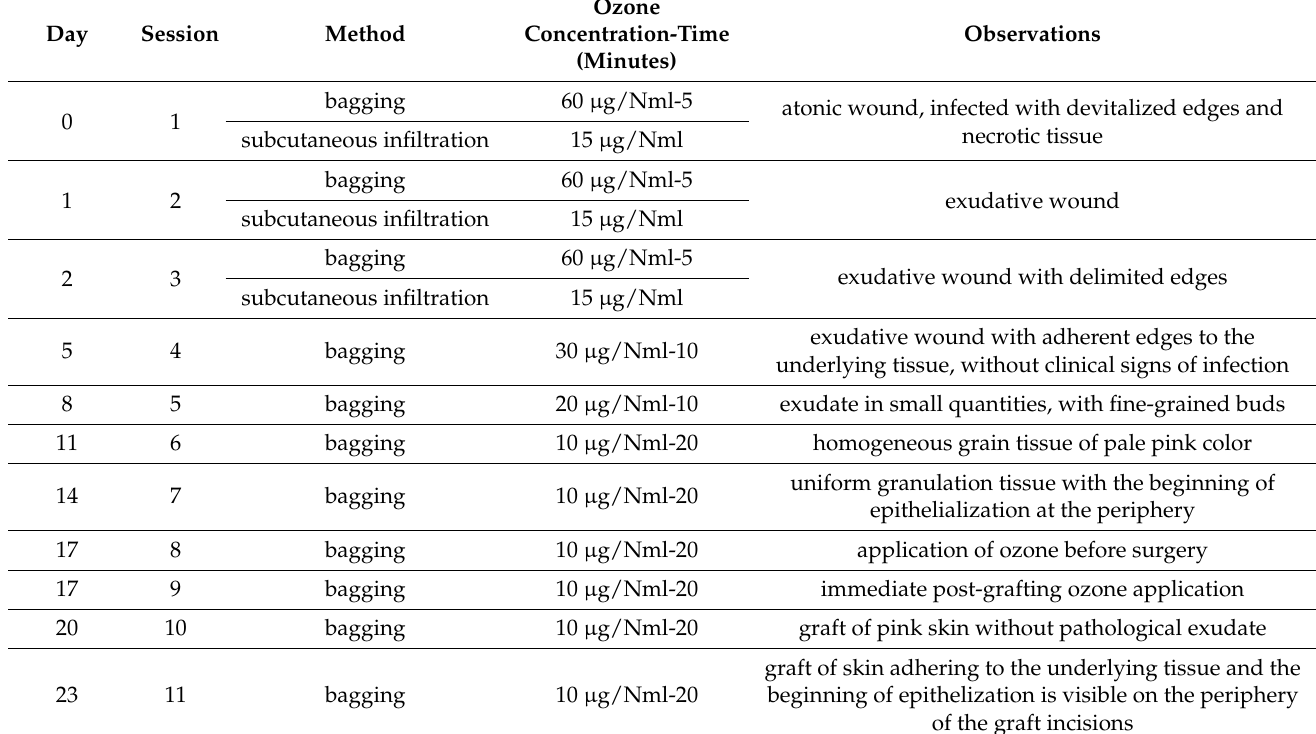
Table 1. Ozone therapy schedule.